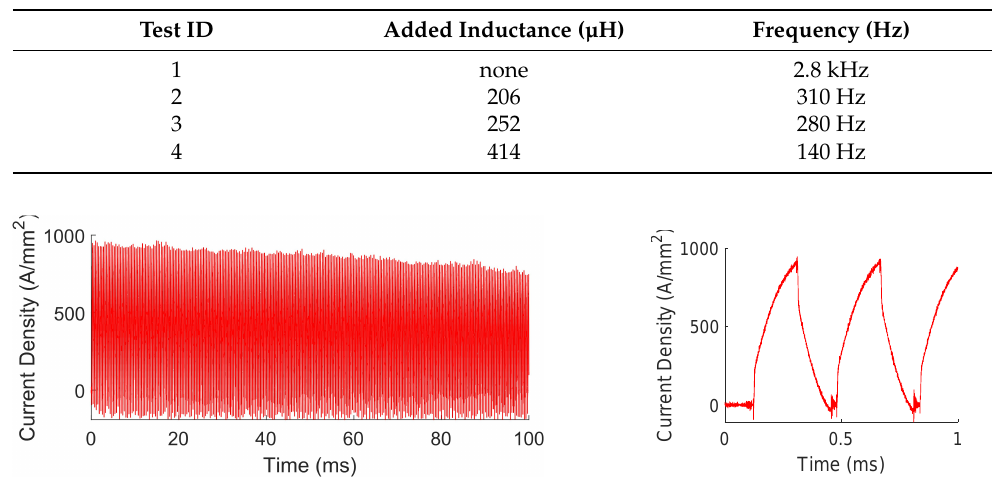
Figure 19. Current amplitude response of battery bank testing using Test ID 1 with 36 V.